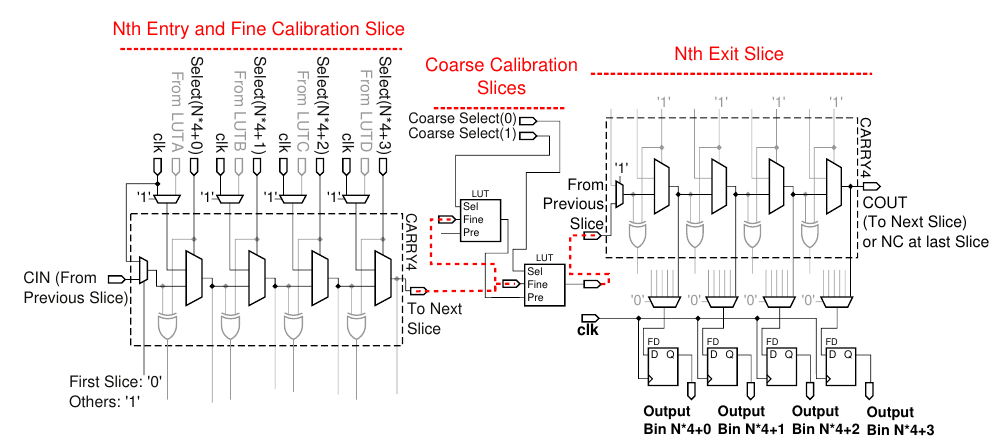
Figure 1: Principle of a delay line based on Xilinx LUT, FD, and CARRY4 elements [Xil16]. In Fine Calibration , selectable entry points of the clock clk are shown to allow for small adjustments of the total path length. The center slices use the output from the Fine Calibration as the input to Coarse Calibration slices based on LUTs. In Exit slices, multiple bins of the delay line are routed to Flip Flop (FF) (FD) primitives as the output values. verify the importance of a thorough analysis for mitigating SCA attacks. This exemplary countermeasure is described in detail in the last subsection of this